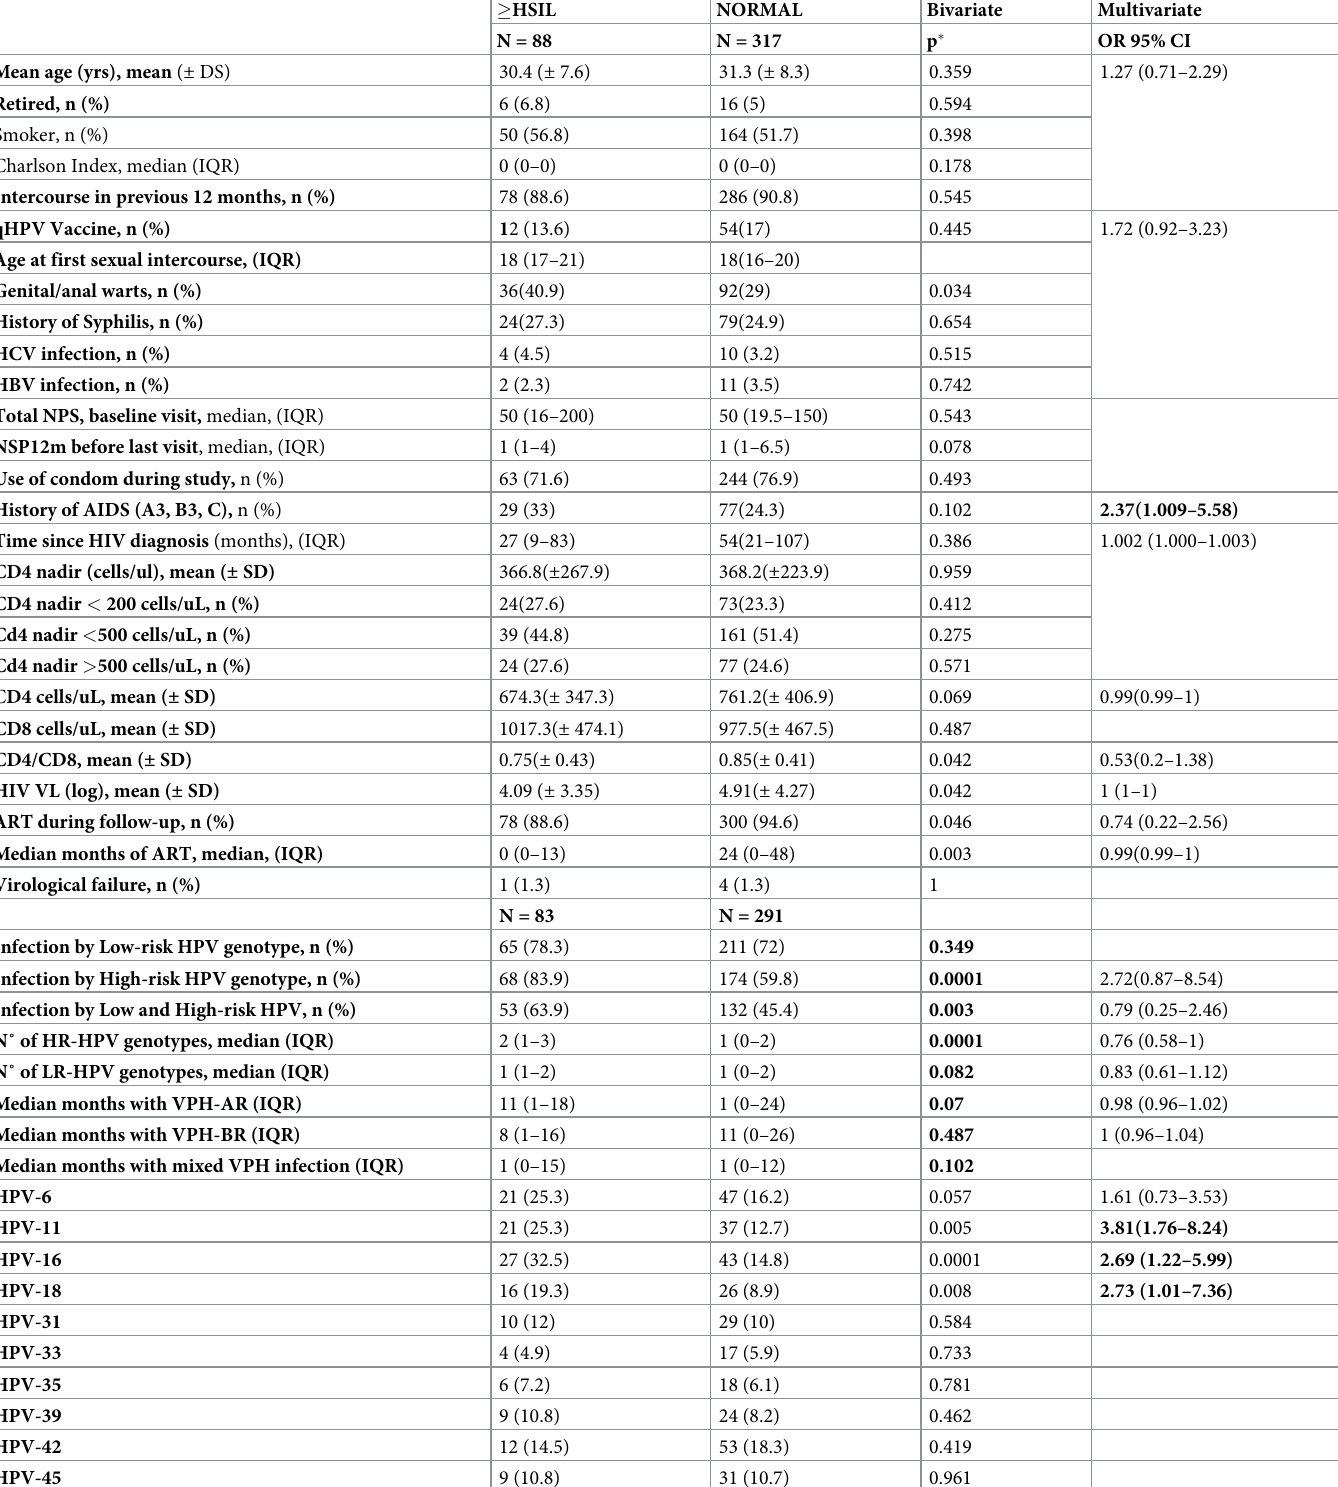
Table 3. Risk factors associated with � HSILs in HIV+ MSM patients. Bivariate and multivariate analysis. � HSIL NORMAL